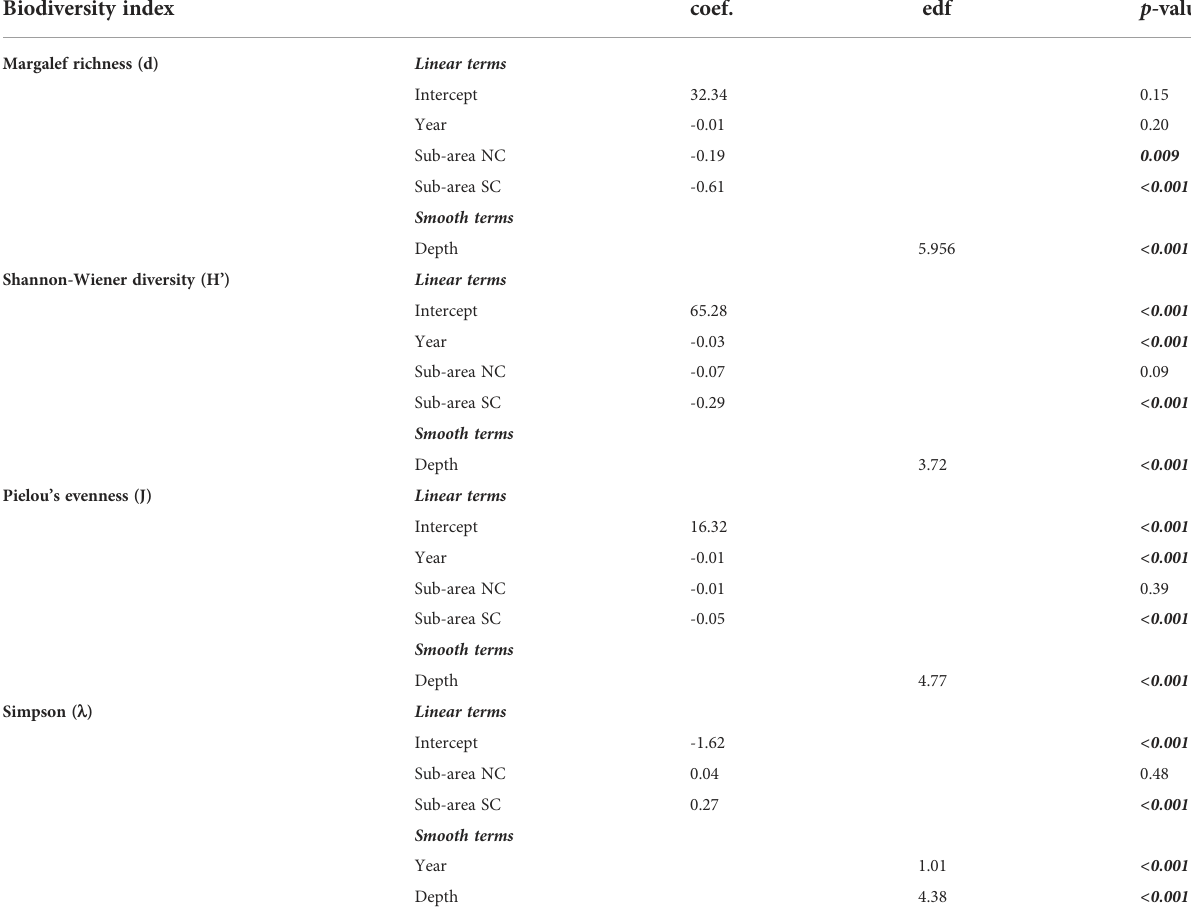
TABLE 1 GAMs estimates for biodiversity indices considering linear (coef.) and smooth effects (estimated degrees of freedom, edf) of temporal, geographical sub-area and depth. Biodiversity